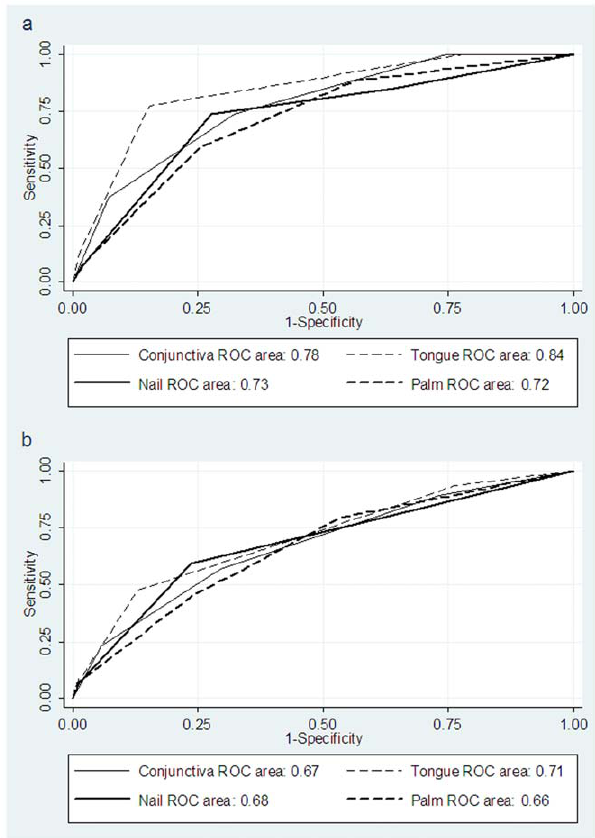
Figure 2. Receiver Operating Characteristics (ROC) curves for all clinical sites for detection of anaemia at haemoglobin cutoff points (a) 7 g/dL and (b) 9 g/dL.